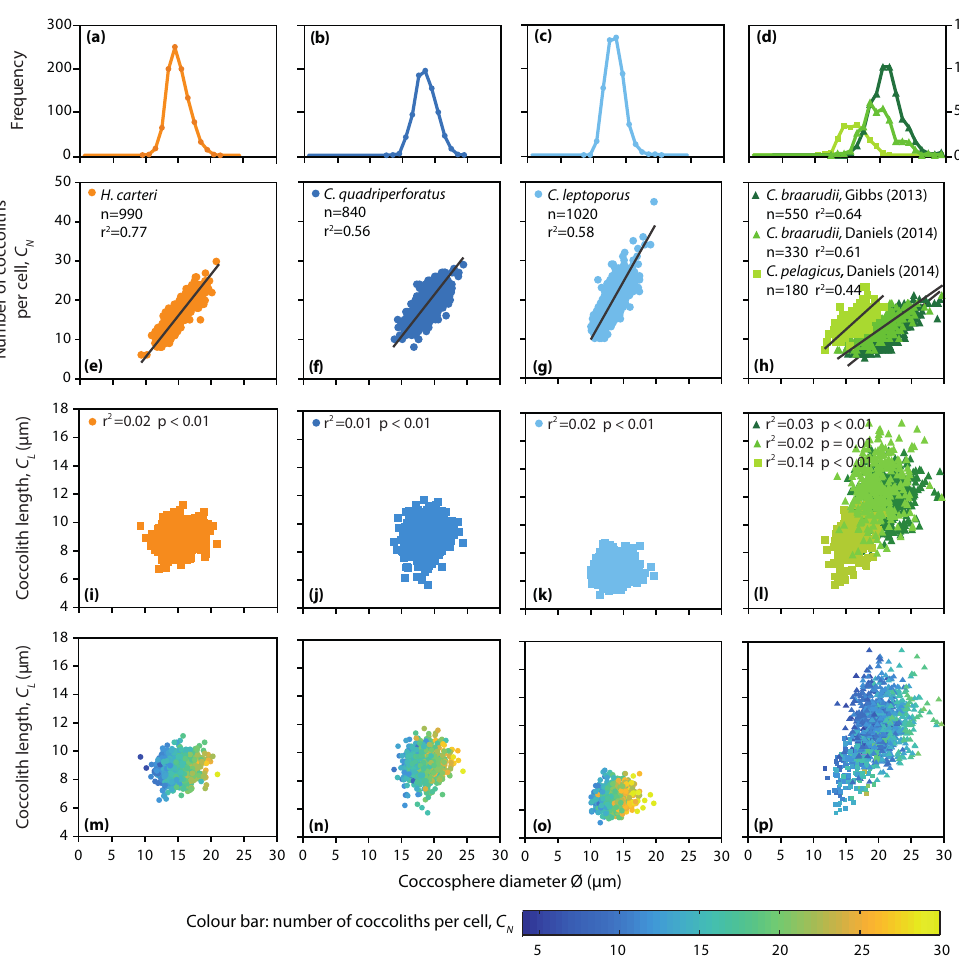
Figure 2. The full range of coccosphere geometry in H. carteri , C. quadriperforatus and C. leptoporus . (a–d) Histograms of coccosphere diameter ( ∅ ) calculated for frequency bins of 1µm size. Note the different frequency scale in plot d . (e–h) Number of coccoliths per cell ( C N ) against ∅ , showing a strong and statistically significant ( p< 0 . 0001) positive relationship. The reduced major axis regression lines show slopes of H. carteri – 2.10 (bootstrapped, 95% confidence interval, CI [2.03, 2.17]); C. quadriperforatus – 2.11 (95% CI [2.02, 2.20]); C. leptoporus – 3.01 (95% CI [2.87, 3.14]); C. braarudii Gibbs et al., 2013 – 1.35 (95% CI [1.27, 1.43]); C. braarudii Daniels et al., 2014 – 1.17 (95% CI [1.09, 1.25]); and C. pelagicus Daniels et al., 2014 – 1.50 (95% CI [1.31, 1.67]). (i–j) Coccolith length ( C L ) with ∅ . (m–p) C L and ∅ with data points coloured by C N . For comparison purposes, we include data for C. braarudii and C. pelagicus that can be found in Gibbs et al. (2013) and Sheward et al. (2014) accompanying Daniels et al.